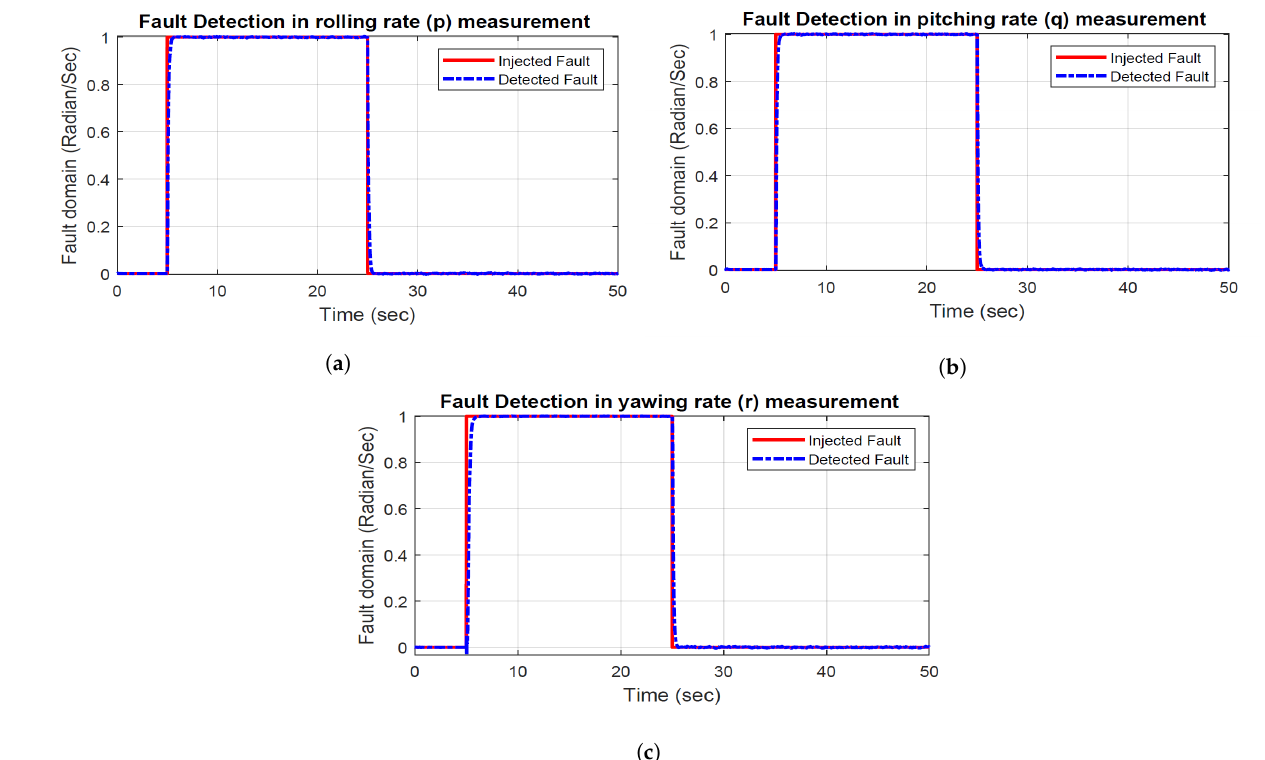
Figure 4. Abrupt fault detection. ( a ) Abrupt fault detection in rolling rate measurement. ( b ) Abrupt fault detection in pitching rate measurement. ( c ) Abrupt fault detection in yawing rate measurement.